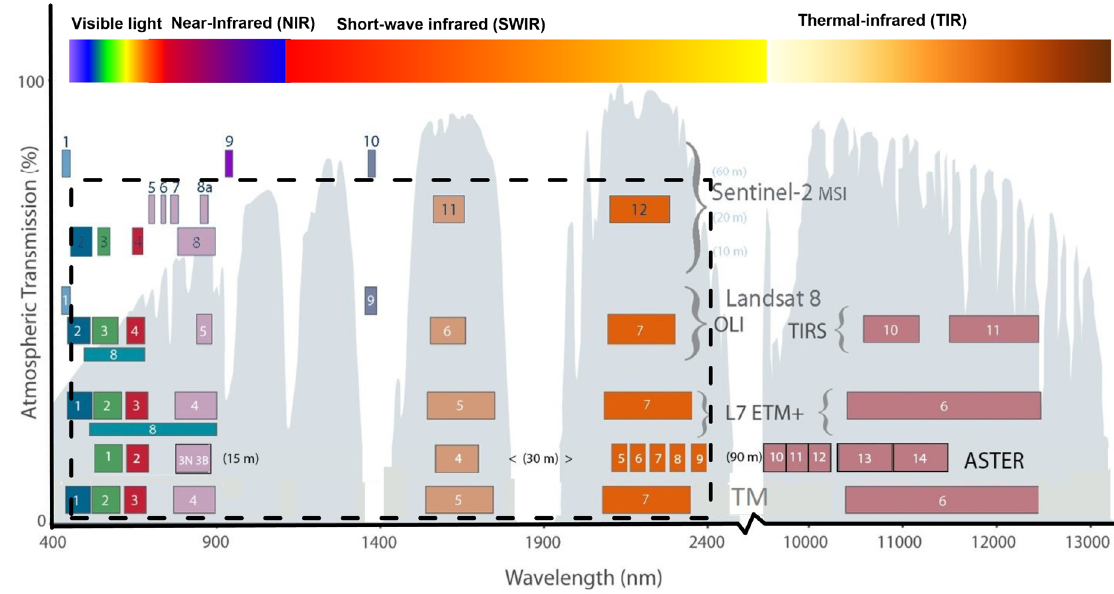
Figure 3. Comparison of satellite images and their bands used in this study (adapted from the USGS website (USGS.gov (accessed on 15 June 2022). The bands that are used in this study are characterized by the dashed rectangle.